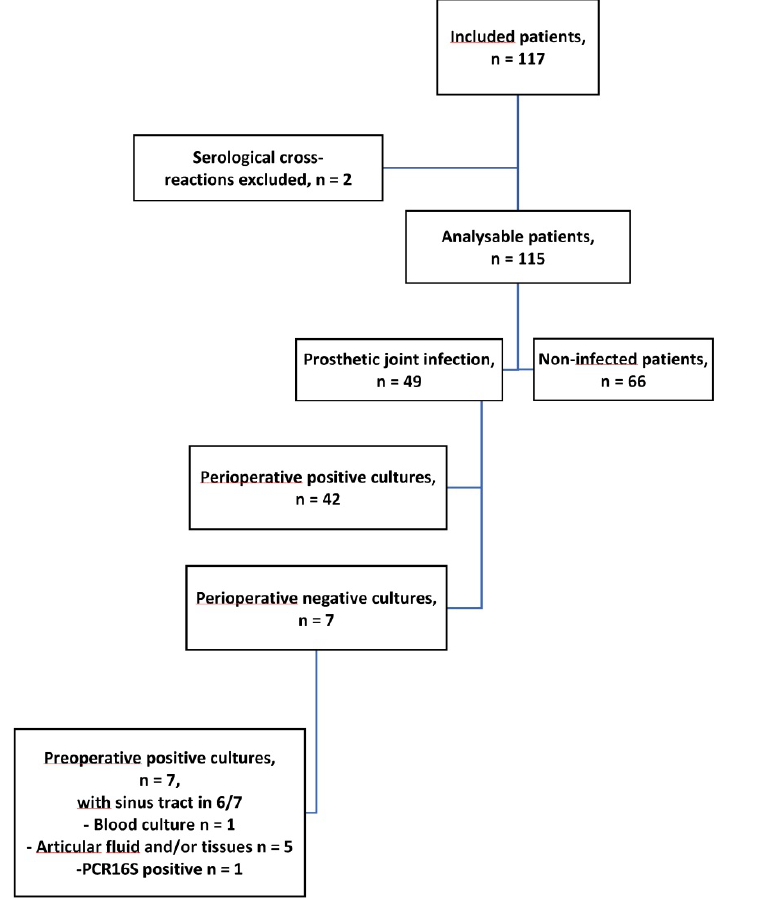
Figure 1. Flow chart of the